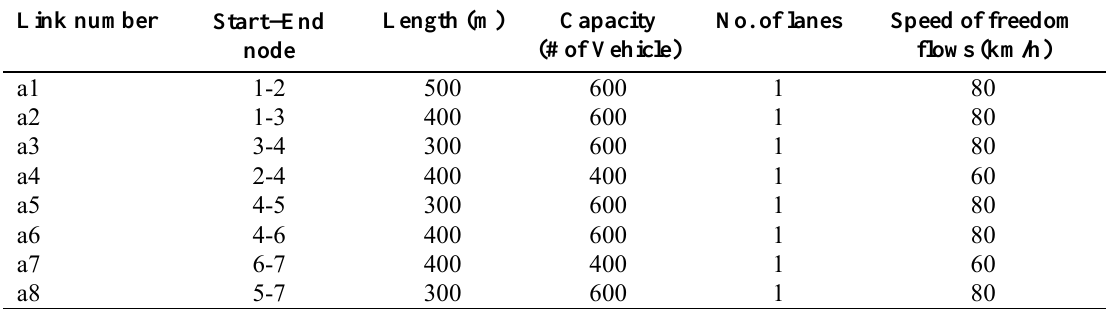
Table 1. Information on links